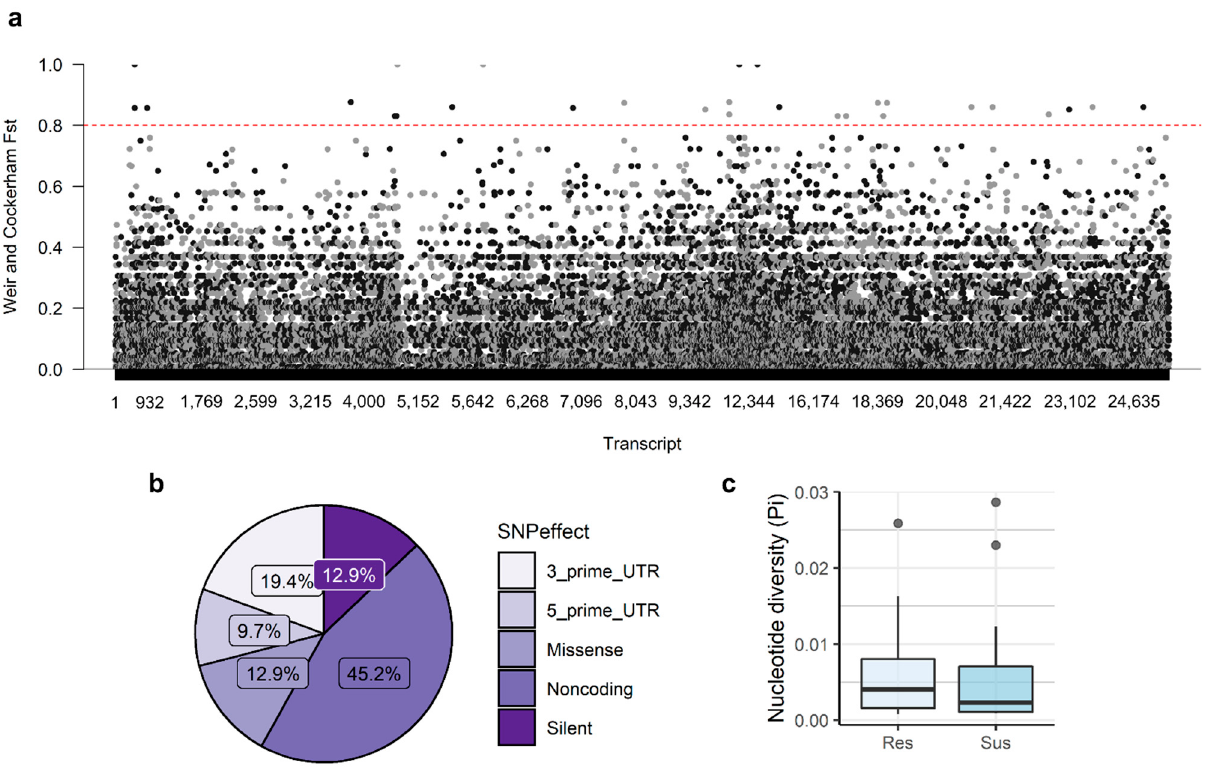
Figure 2. Genetic differentiation (F ST ) between susceptible and resistant groups (a) and charac- terization of the SNPs with F ST ≥ 0.80 (b,c). ( a ) Manhattan plot of F ST values obtained between susceptible and resistant samples. The red intermittent line indicates F ST = 0.80. ( b ) SNP effects of the SNPs with F ST ≥ 0.80. ( c ) Nucleotide diversity ( π ) of the regions containing the SNPs with F ST ≥ 0.80, calculated using a sliding window of 200 bp. Res—resistant; Sus—susceptible. Table 2. Summary of the SNP